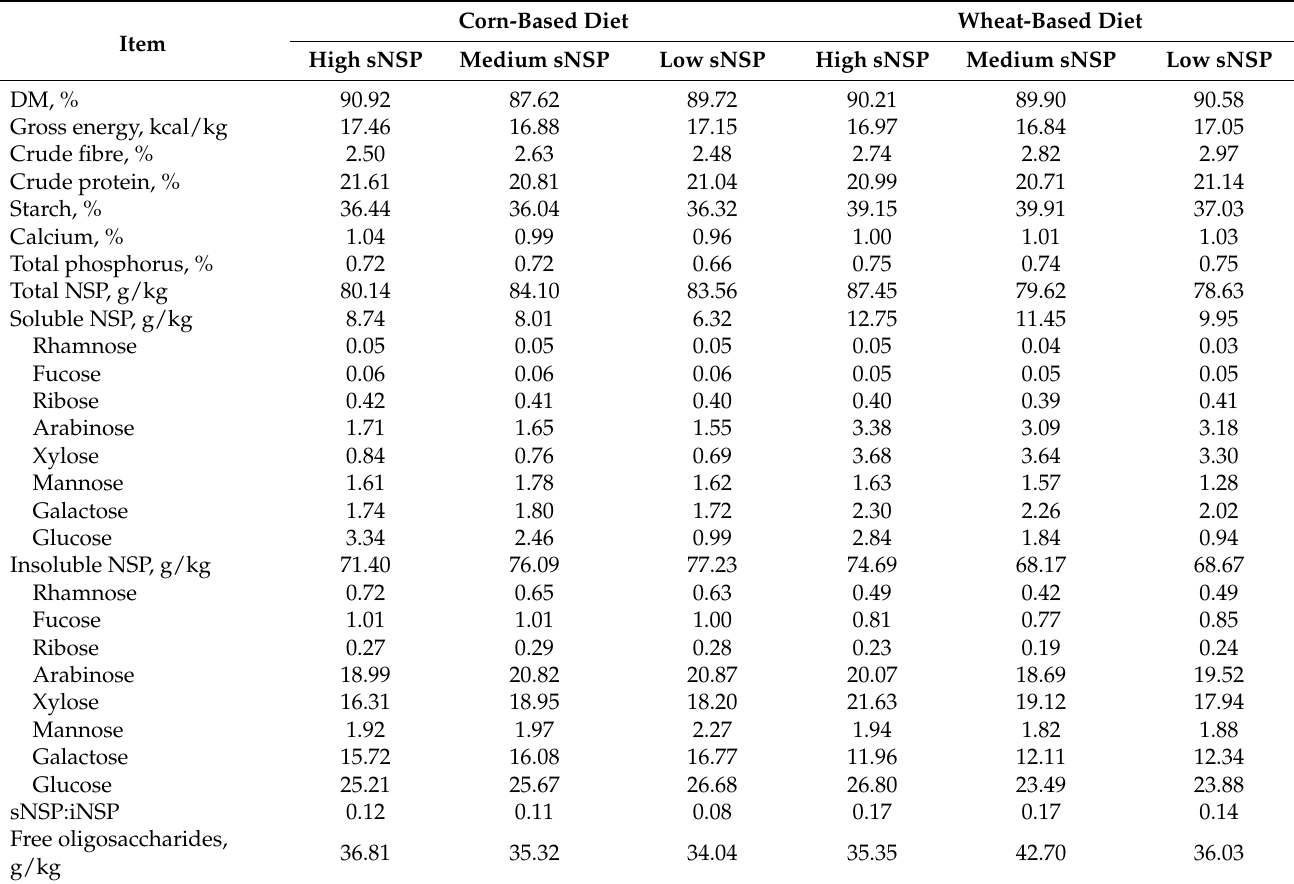
Table 5. Analysed nutrient composition of grower diets (as-fed